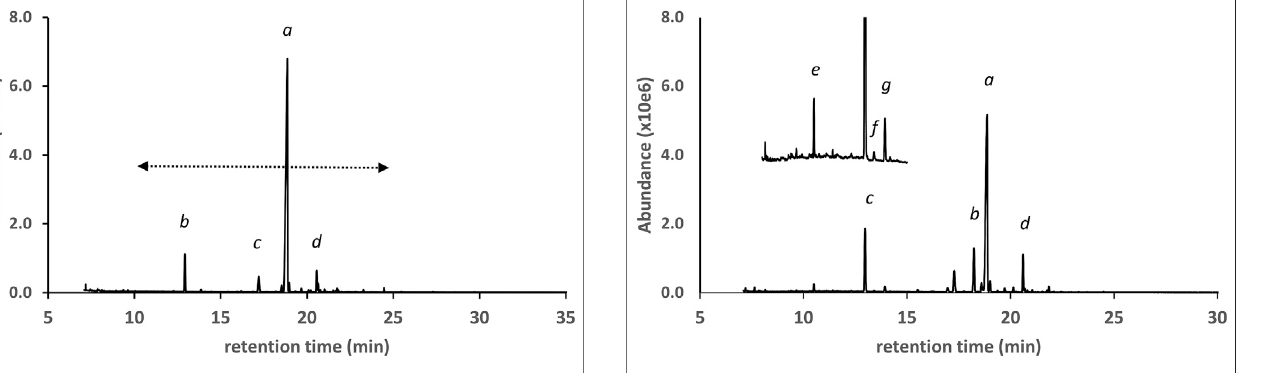
FIGURE3 | GC-MSchromatogram fora cannabis vaping liquid inwhich the predominant cannabinoid was d9THC( a ), and other cannabinoids include CBD, CBG, and CBN (peak labels b , c , and d , respectively). The cannabinoid TMS derivatives retention range (ca. 10 – 25 min) is indicated by the double arrow.